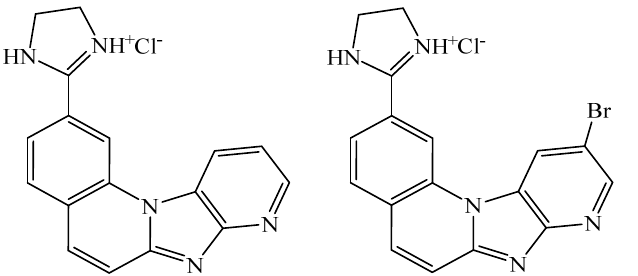
Figure 2. Tetracyclic imidazo[4,5- b ]pyridine derivatives substituted with a cyclic amidino group exert potent antiproliferative activity.